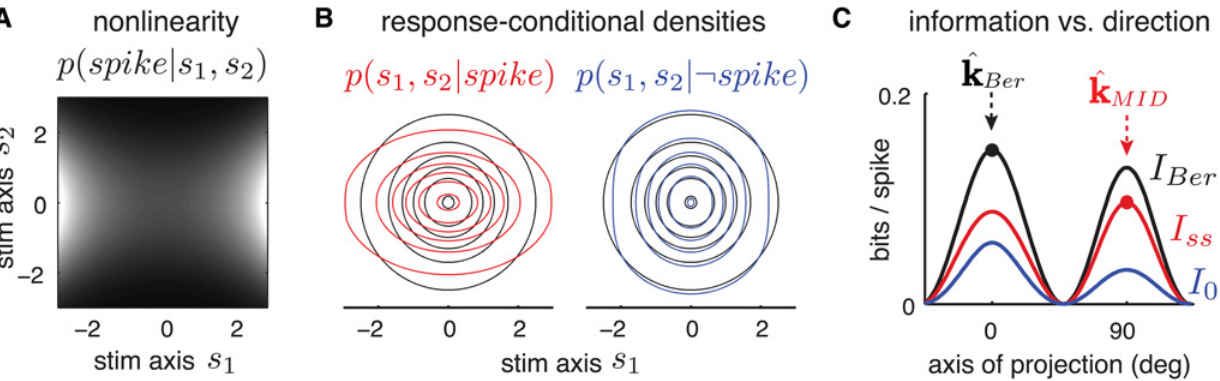
^ k Fig 5. A second example Bernoulli neuron for which MID fails to identify the most-informative one-dimensional subspace. The stimulus space has two dimensions, denoted s 1 and s 2 , and stimuli were drawn iid from a standard Gaussian N (0,1). (A) The nonlinearity f ( s 1 , s 2 ) = p ( spike j s 1 , s 2 ) is excitatory in s 1 and suppressive in s 2 ; brighter intensity indicates higher spike probability. (B) Contour plot of the stimulus-conditional densities given the two possible responses: “ spike ” (red) or “ no-spike ” (blue), along with the raw stimulus distribution (black). (C) Information carried by silences ( I 0 ), single spikes ( I ss ), and ^ k total Bernoulli information ( I Ber = I 0 + I ss ) as a function of subspace orientation. The MID estimate ¼ 90 (cid:5) is the maximum of I ss , but the total Bernoulli MID ^ k information is in fact 13% higher at ¼ 0 (cid:5) due to the incorporation of no-spike information. Although both stimulus axes are clearly relevant to the neuron, Ber MID identifies the less informative one. As with the previous figure, equations (19) and (20) detail the equivalence between I Ber and L lnb , so that this figure can be viewed from either an information-theoretic or likelihood-based